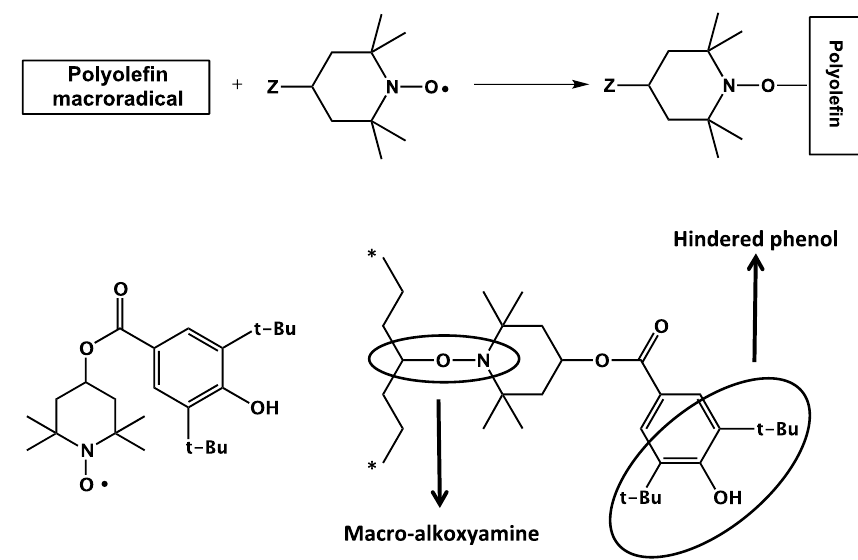
Scheme 1. Schematic representation of nitroxide radical coupling (NRC) reaction, structure of